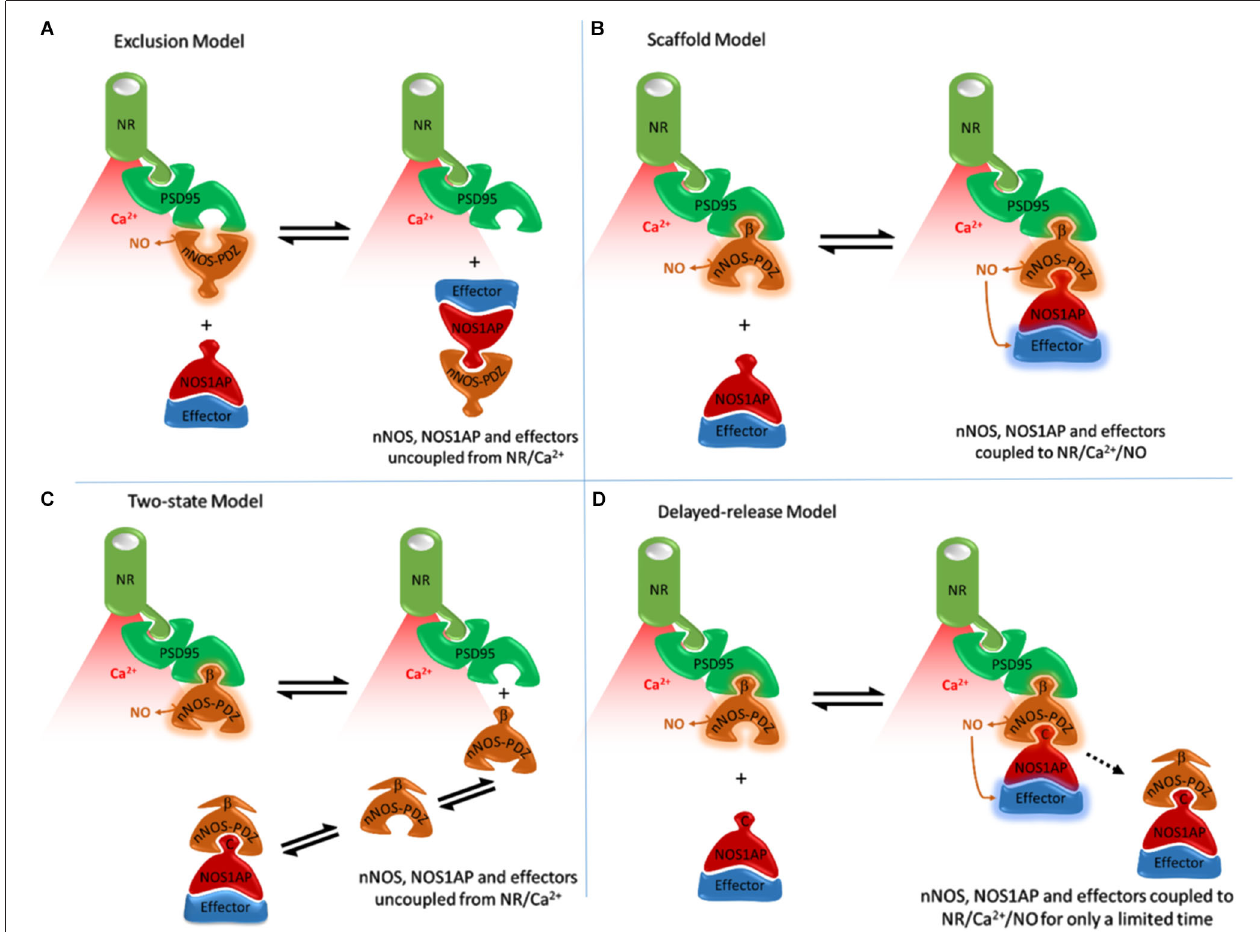
activated nNOS (Fang et al., 2000; Cheah et al., 2006; Li et al., 2013). But it is not consistent with cell-free experiments in which NOS1AP competes with PSD95 for binding nNOS (Jaffrey et al., 1998). (C) The Two-state model. The extended PDZ domain of nNOS is proposed to exist in two conformational